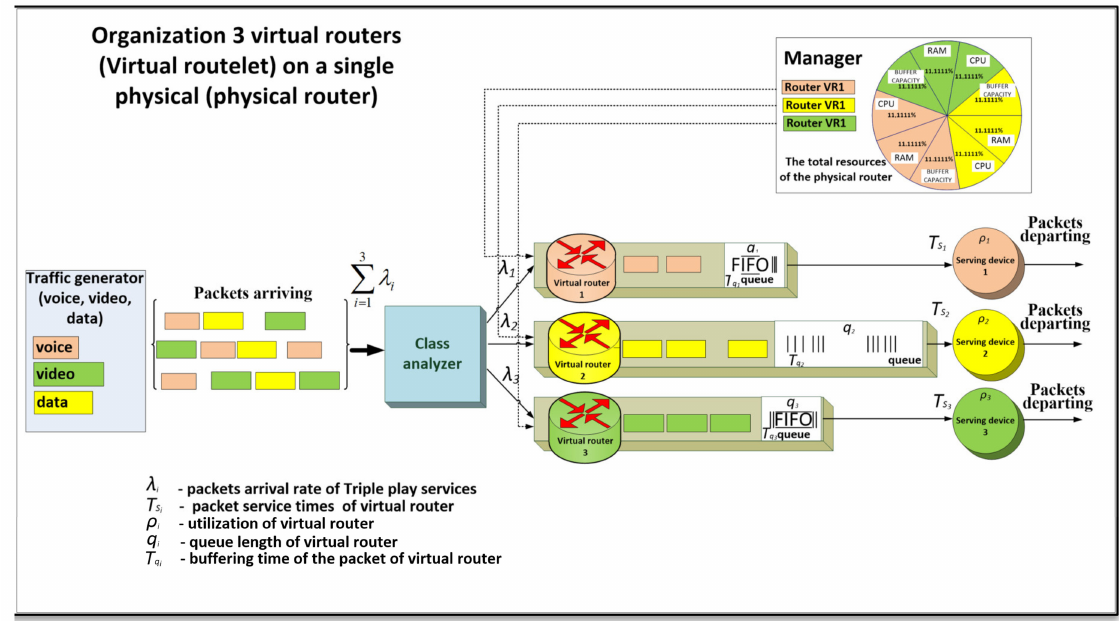
Figure 1. Conceptual model of a multiple virtual router with dynamic resource